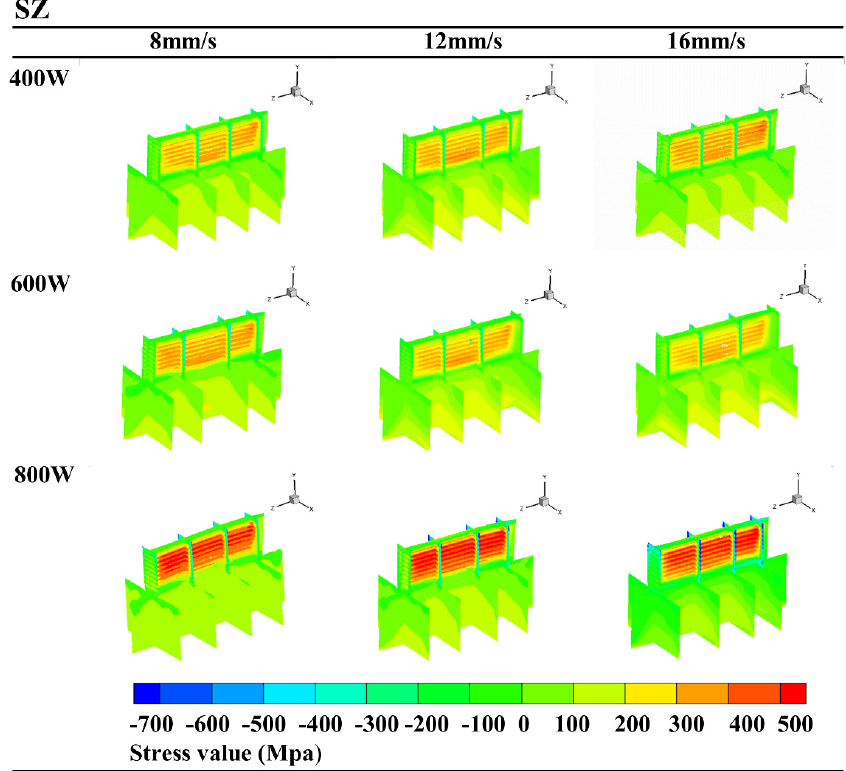
Figure 8. The ZZ stress distributions under different scanning speed and laser power values when the layer thickness is 0.4 mm.